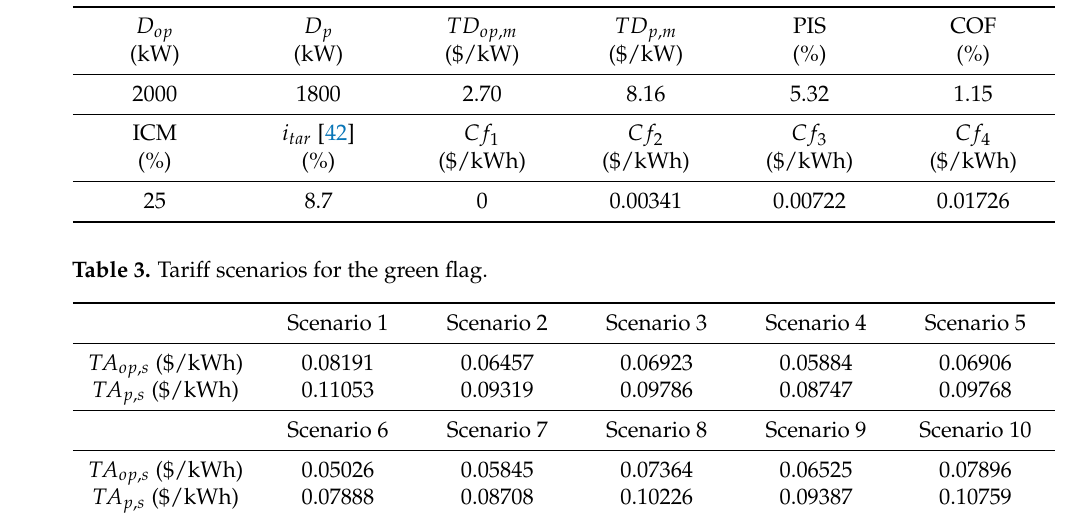
Table 2. Tariff structure parameters.